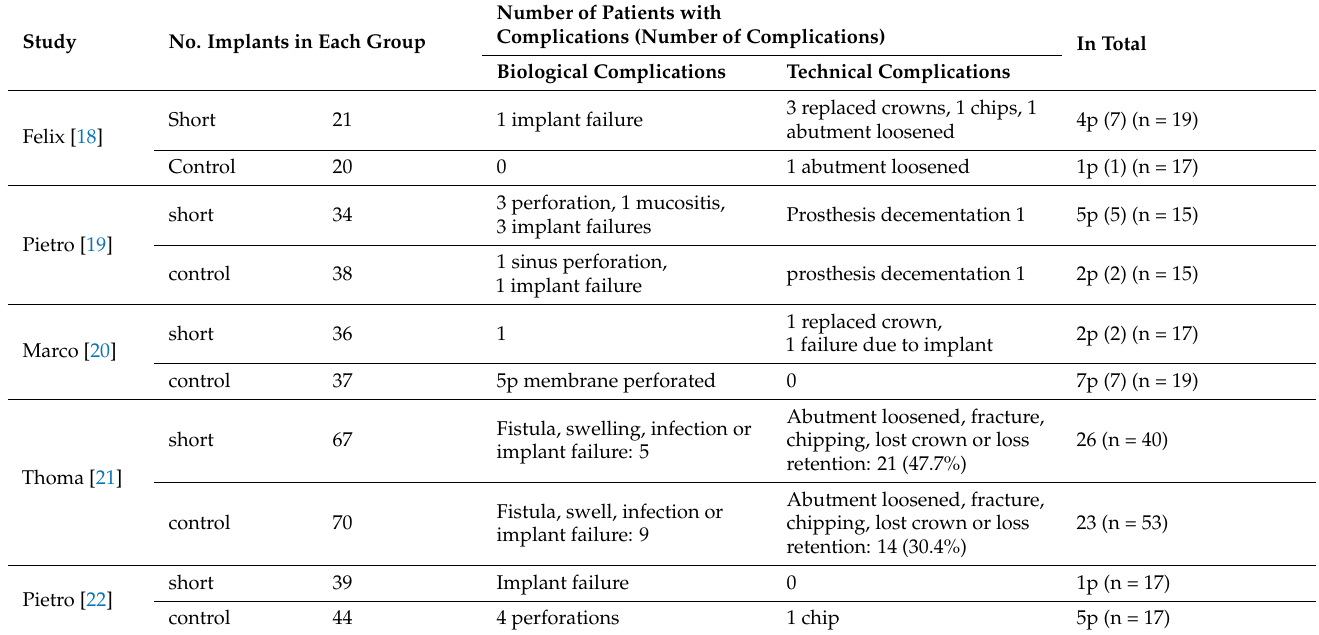
Table 4. List of complications by study